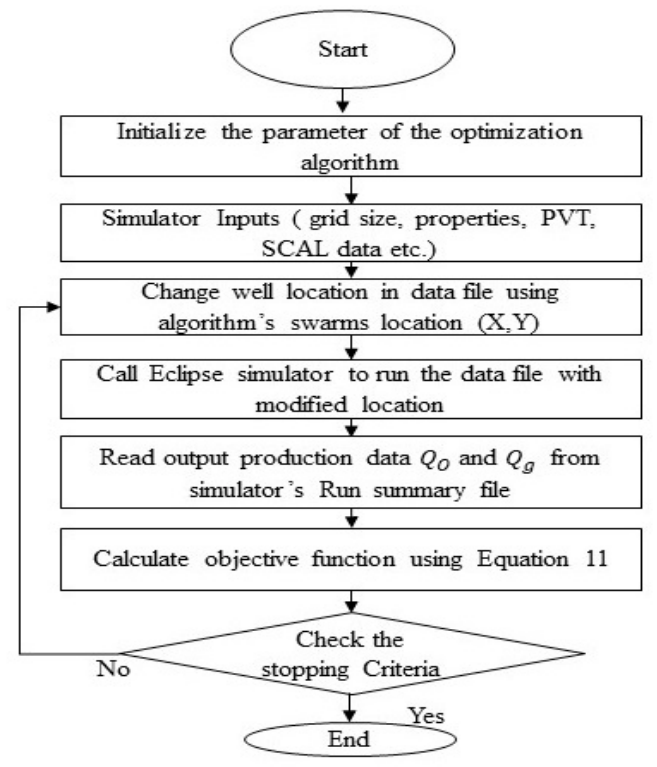
Figure 1. A general flow chart for searching the maximum net present value.